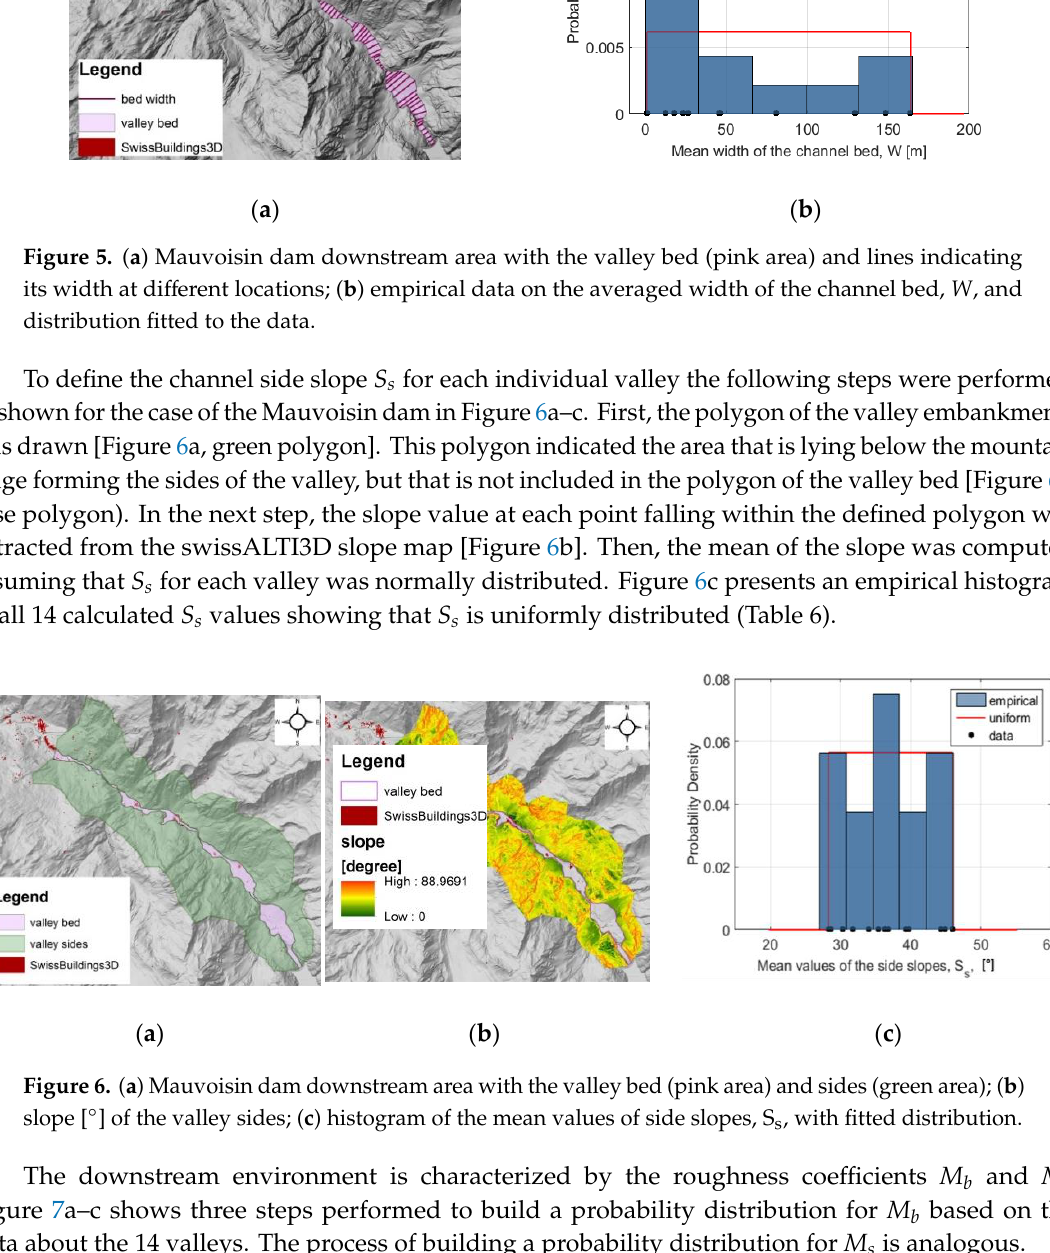
Table 5. Roughness coefficients for different types of land cover. Landcover Type (swissTLM3D)